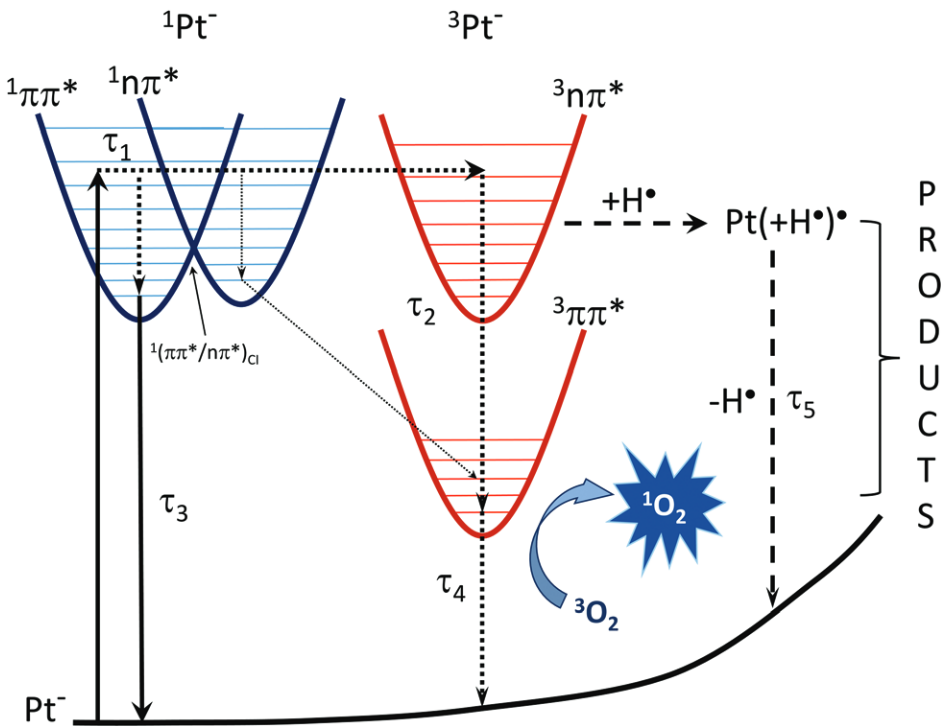
Figure 16. Relaxation pathways of Ptr − 1 in aqueous solutions. Solid lines indicate radiative transi- tions, dashed lines—hydrogen transfer pathways, while the dotted lines indicate nonradiative decay transitions [180]. © 2022 Royal Society of Chemistry.